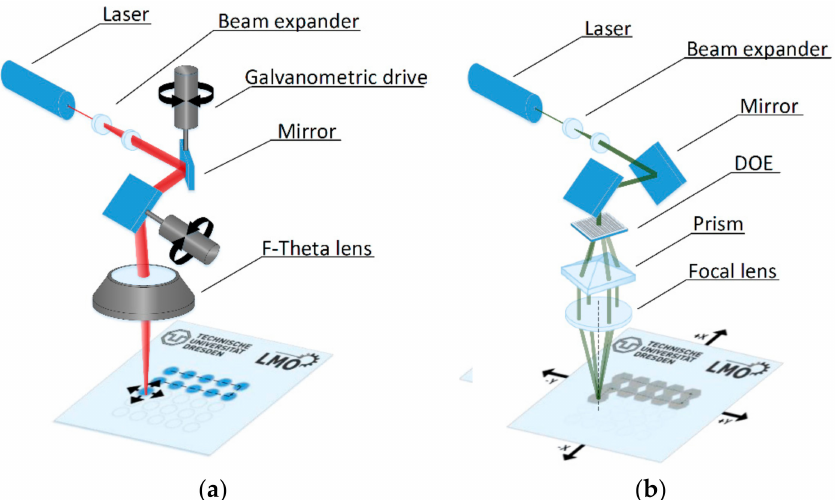
Figure 1. Schematics of ( a ) direct laser writing (DLW) and ( b ) direct laser interference patterning (DLIP). The DLW system operated at 1064 nm with pulse durations of 8 ns, 50 ns or 200 ns. For the DLIP technique, a laser beam was split with a diffractive optical element and recombined by a lens. The interference pattern was guided over the surface using 2 linear stages. Overlapping 4 beams lead to interference in the focal volume, resulting in an intensity with a dot-like distribution. Moving the target in X and Y directions with high precision linear stages, large areas can be